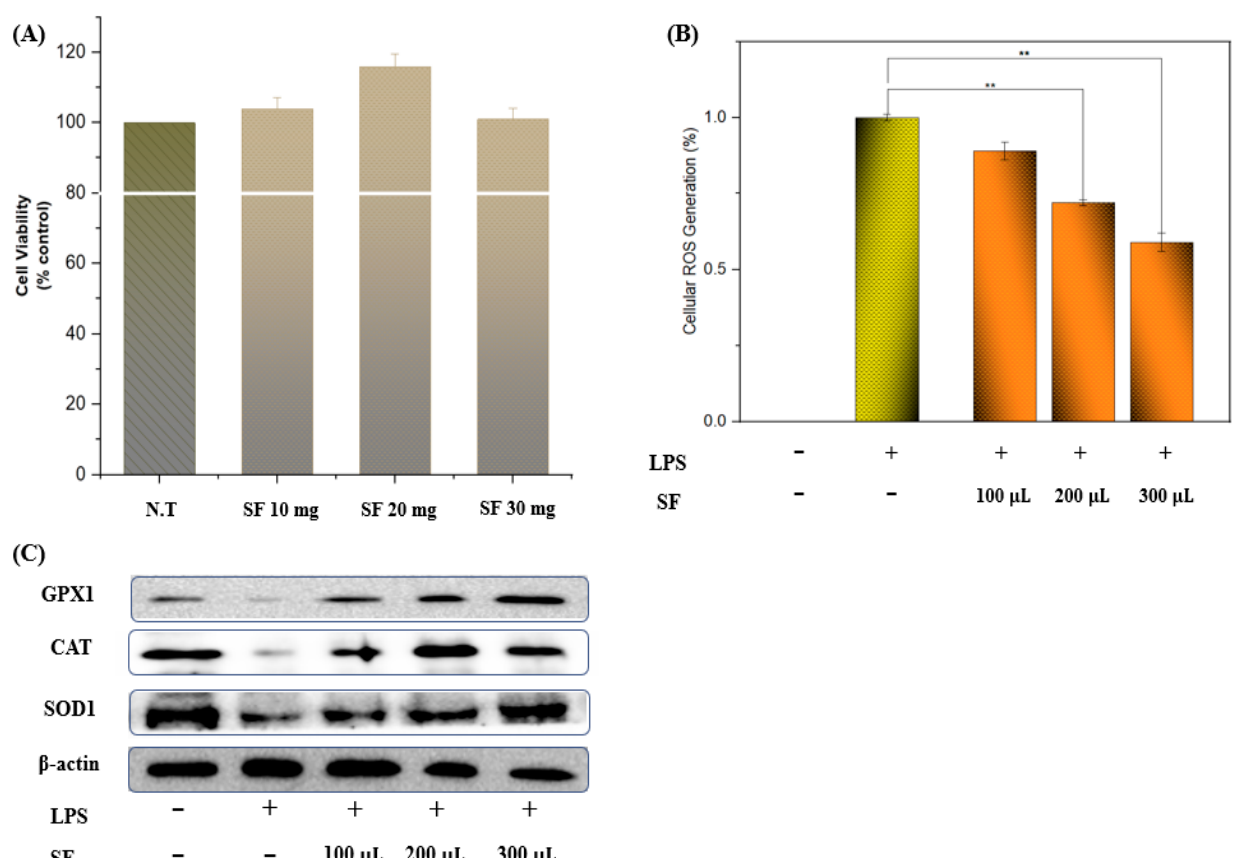
Figure 2. Cellular viability and antioxidant activity of optimized Sargassum fusiforme (SF) extracts. Cell viability of optimized SF extracts ( A ), ROS scavenging activity of SF extracts ( B ), glutathione peroxidase 1 (GPx-1), catalase (CAT), and superoxide dismutase 1 (SOD-1) protein expression ( C ) in RAW cells were measured as described in materials and methods. Results are expressed as the mean ± SD of three separate experiments. LPS: 1 µ g/mL. ** p < 0.01 as compared with LPS alone.